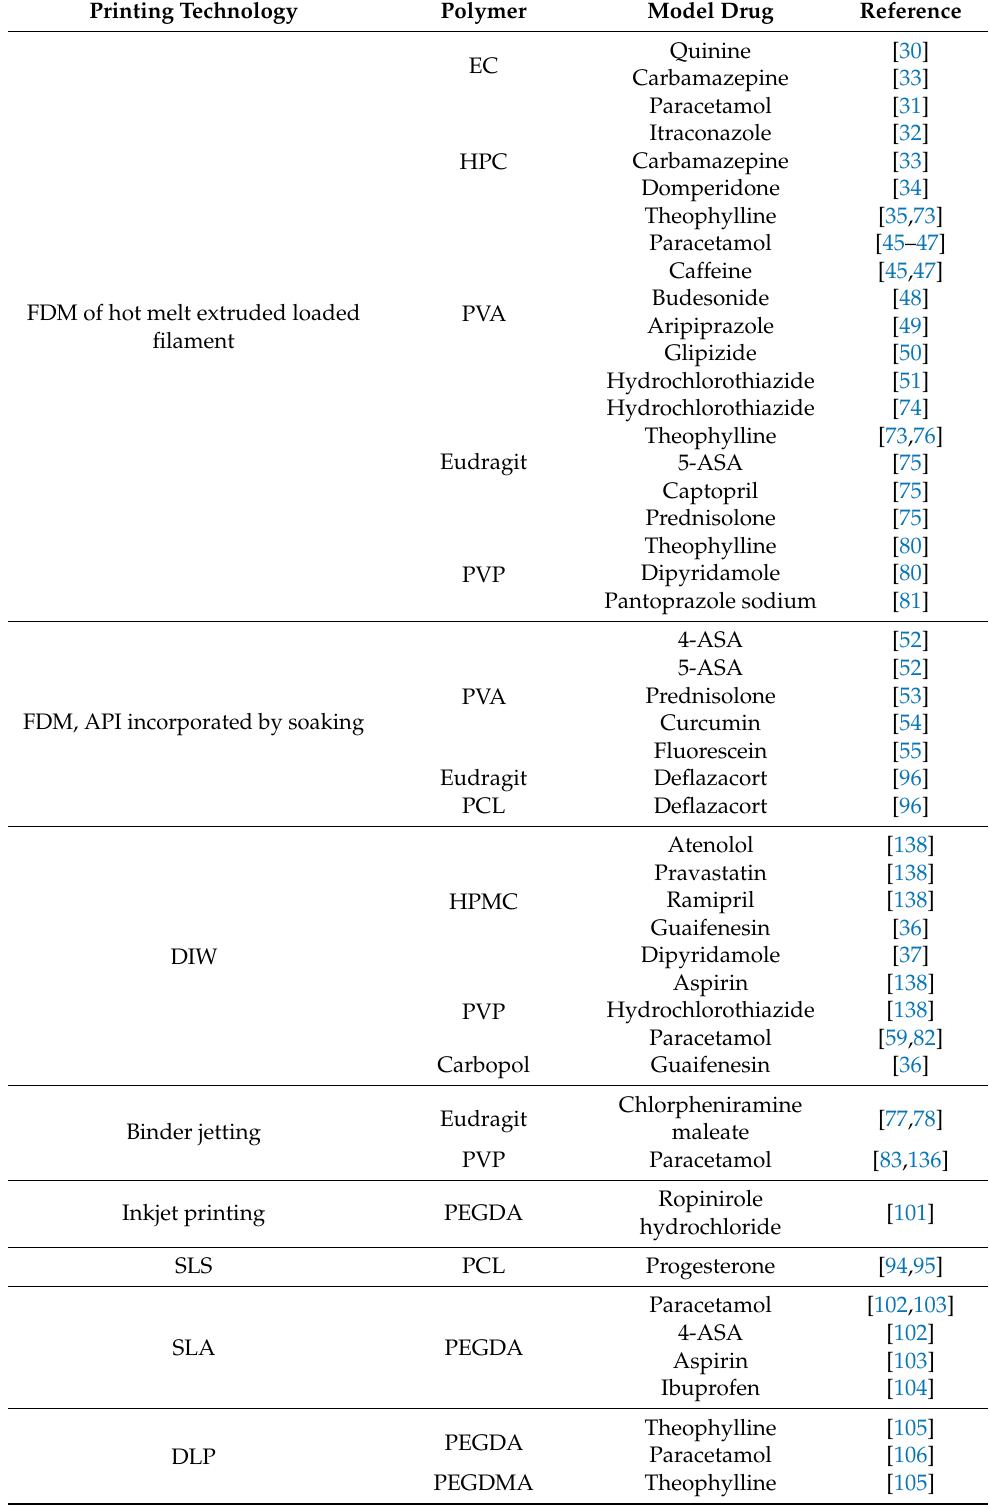
Table 2. Research done on oral tablet printing using various polymers and 3D printing